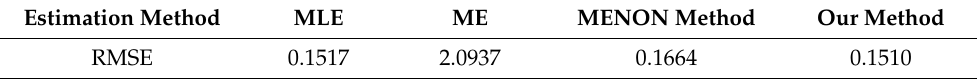
Table 9. The statistics of estimation accuracy in measured Weibull distribution ( k = 1). Estimation